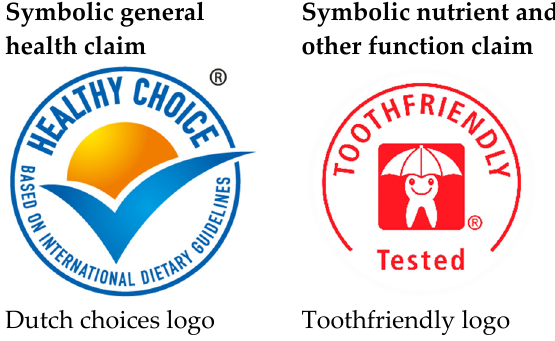
Figure 1. Examples of symbolic claims.